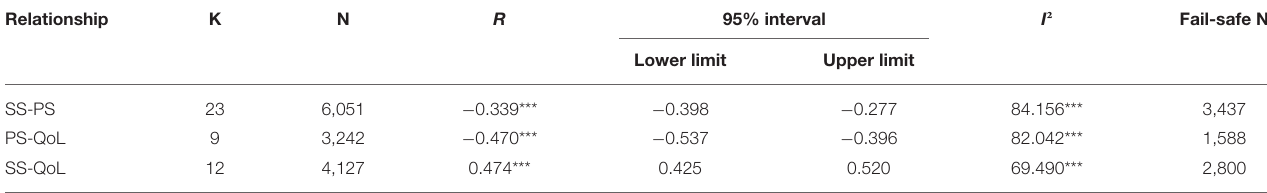
TABLE 3 | Analysis of correlation.